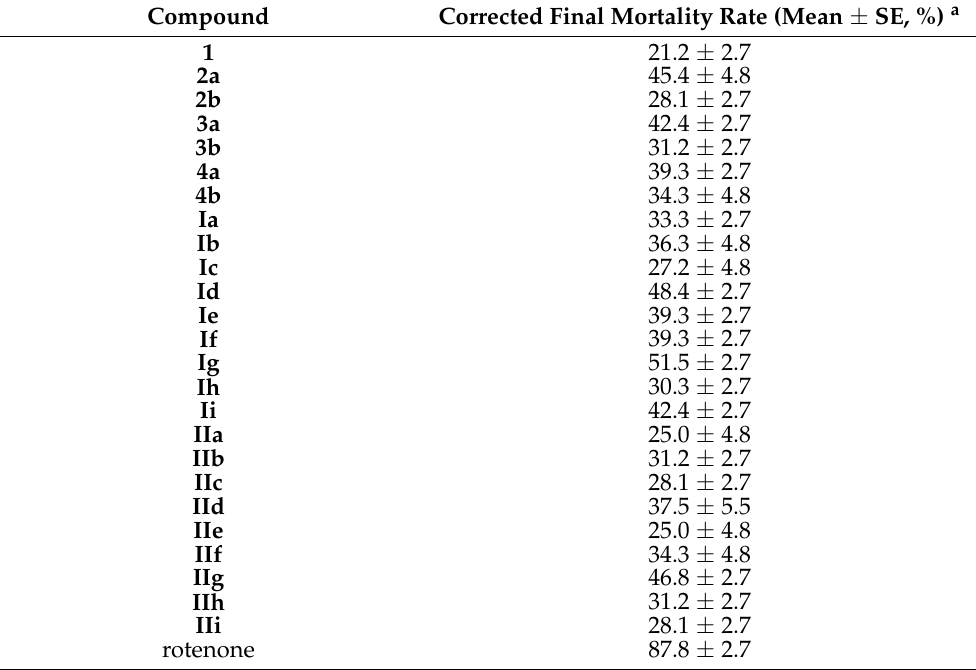
Table 1. Insecticidal activity of compounds I ( a – i )– II ( a – i ) against M. separata at 1 mg/mL. Compound